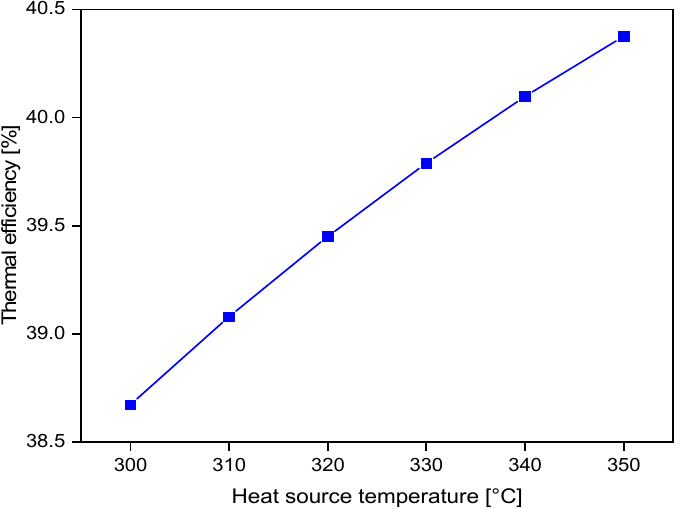
Figure 8. Variation of thermal efficiency with heat source temperature in August.